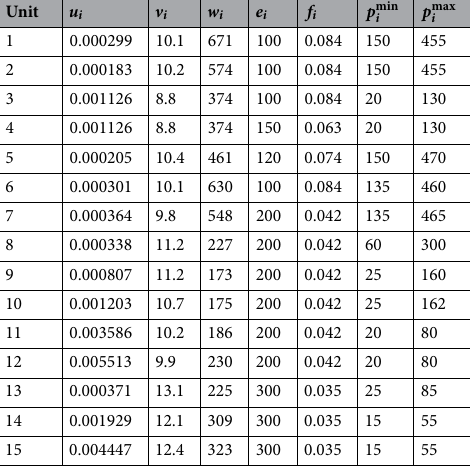
Table 10. Thermal units cost input data for case study-IV.